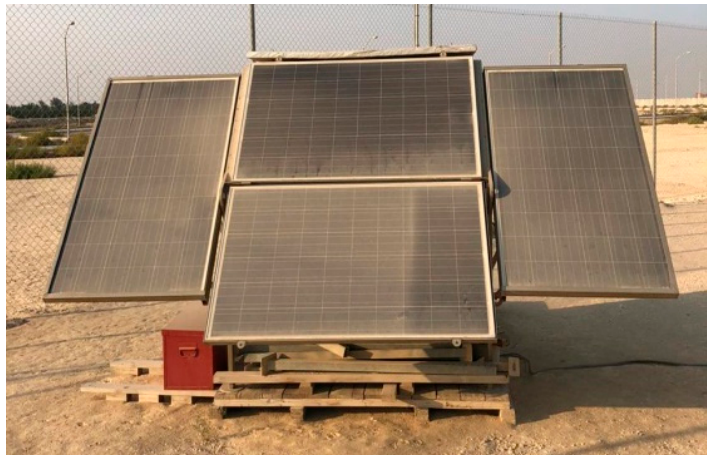
Figure 11. Dust accumulation in six months at KFUPM beach.